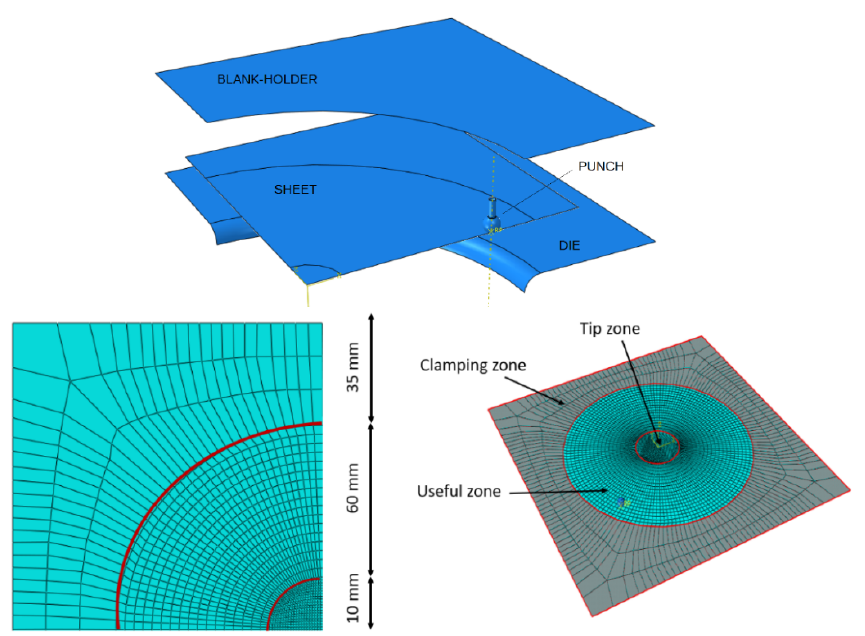
Figure 6. The 3D CAD model, FE meshing, and partition of initial